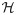
Locus of the trendline parameters (a, b) in the hyperbolic plane H for the arc-cosine distance dijA and the 11 countries analyzed, t ∈ [1960, 2015].The diameter and color of the circles are proportional to the value of R2. The dashed line delimits the clusters C1 and C2.